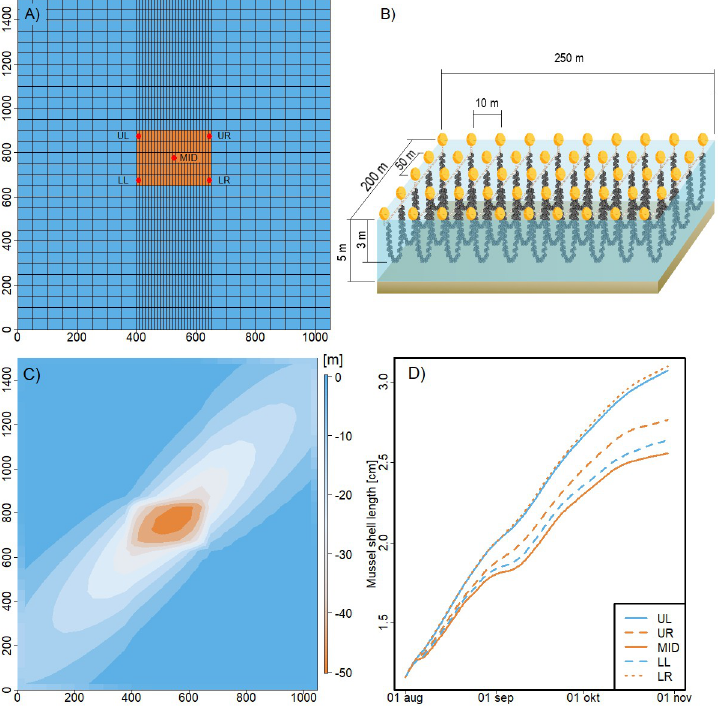
Fig 5. Farm scale model. A) Model grid with the mussel farm (250x200m) located in the middle (red cells) and 5 positions indicated: upper right (UR), upper left (UL), middle (MID), lower left (LL) and lower right (LR), B) conceptual diagram of the mussel farm and C) % Chl-a depletion in the farm area and D) increase of mussel shell length (cm) over time from the 5 positions in the farm.